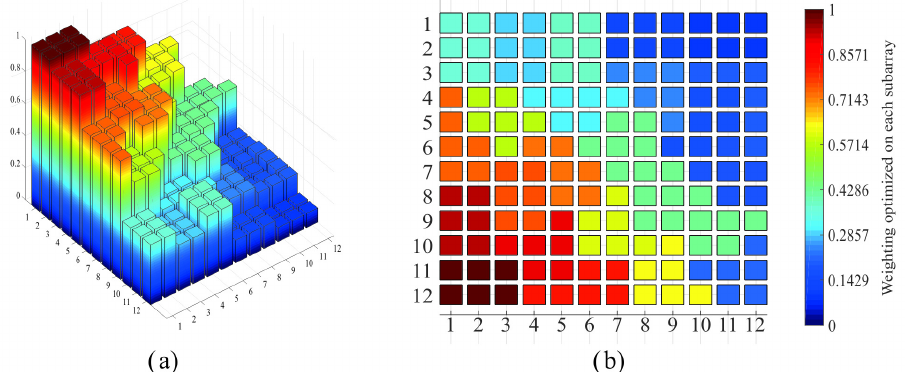
Figure 3. Distribution of optimization weighting assigned to each subarray (1st quadrant): ( a ) dis- tribution of the optimized weighting of the subarray (3-D), and ( b ) distribution of the optimized weighting of the subarray (top view).